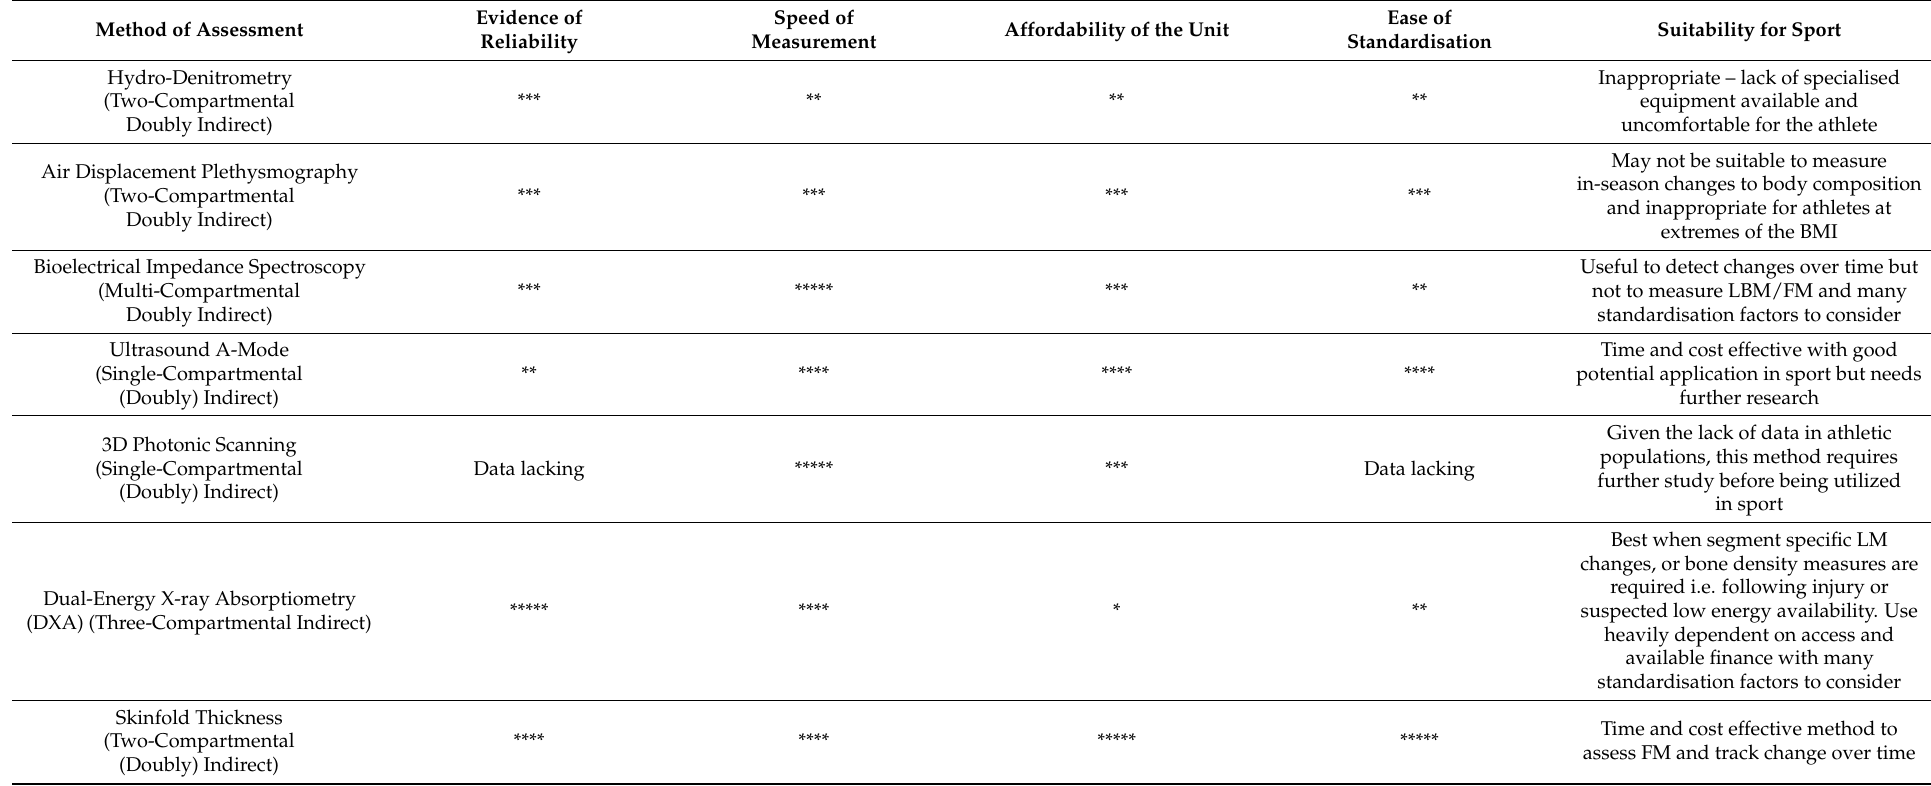
Table 1. An overview of the different methodologies for assessing body composition in sport. The authors of the current paper met to rate each technique on a number of key consideration based upon the current balance of evidence within the scientific